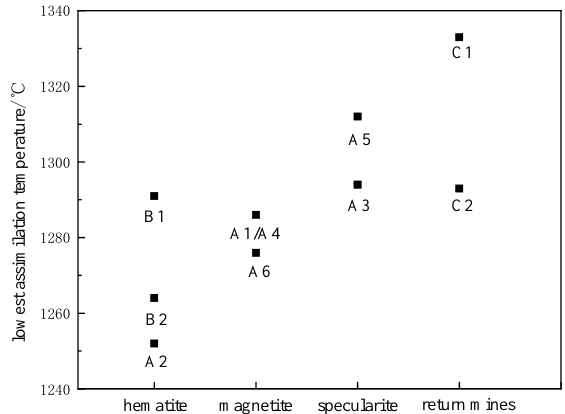
Figure 4. Influence of iron ore powder type on assimilation temperature. As shown in Figure 5, the influence of LOI of iron ore powder containing crystal water on assimilation temperature was analyzed. It was found that the LOI of iron ore powder is negatively correlated with the assimilation temperature. The higher the LOI, the lower the assimilation temperature. The burning loss is mainly caused by internal structural changes caused by the decomposition of crystal water as a result of the heating of iron ore powder. Previous studies have shown that during the calcinating and heating process of iron ore powder, the crystal water in the mineral is decomposed, and a large number of cracks or even holes is generated in the internal structure. The specific surface area and porosity of each mineral increases, which can enhance the effective diffusion coefficient of CaO in iron ore powder and improve the mass transfer rate between slag system components in the binder phase of sinter [18]. At the same time, with increased contact area between the oxides, the reaction activity is increased.